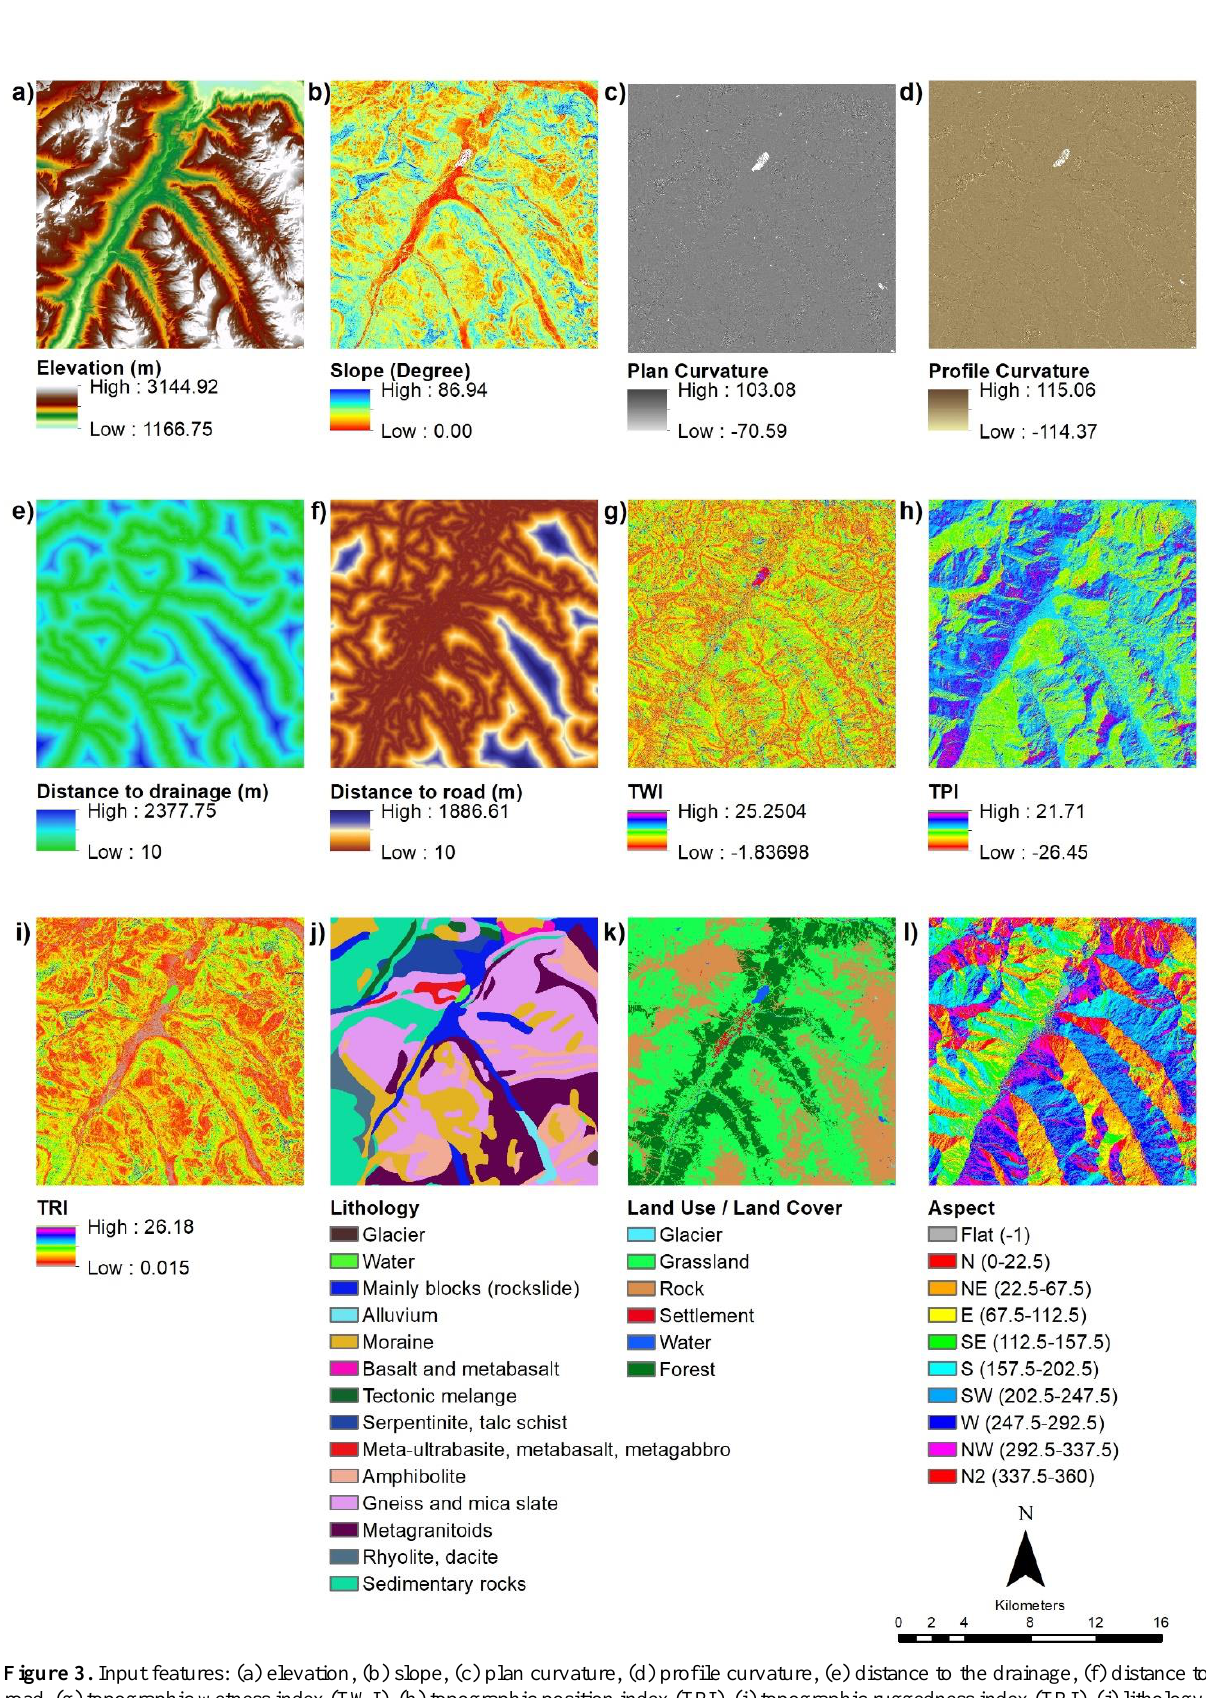
Figure 3. Input features: (a) elevation, (b) slope, (c) plan curvature, (d) profile curvature, (e) distance to the drainage, (f) distance to road, (g) topographic wetness index (TWI), (h) topographic position index (TPI), (i) topographic ruggedness index (TRI), (j) lithology, (k) land use/ land cover, (l)